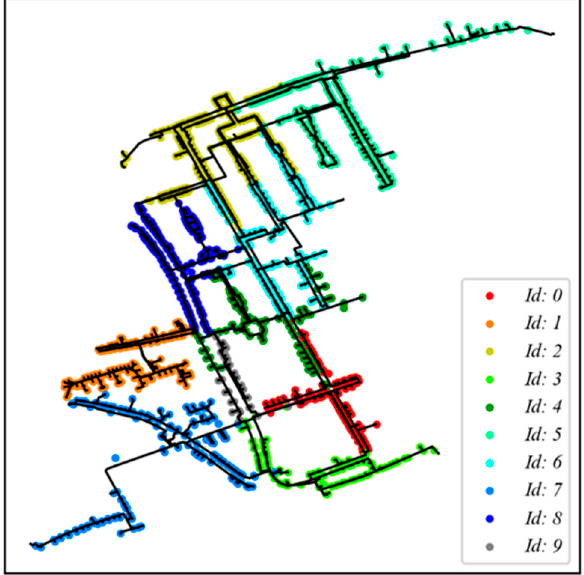
Figure 2. Investigated low-voltage (400 V) grid with 10 subgrids and 3100 consumers. The lines are colored according to the belonging subgrid ID.